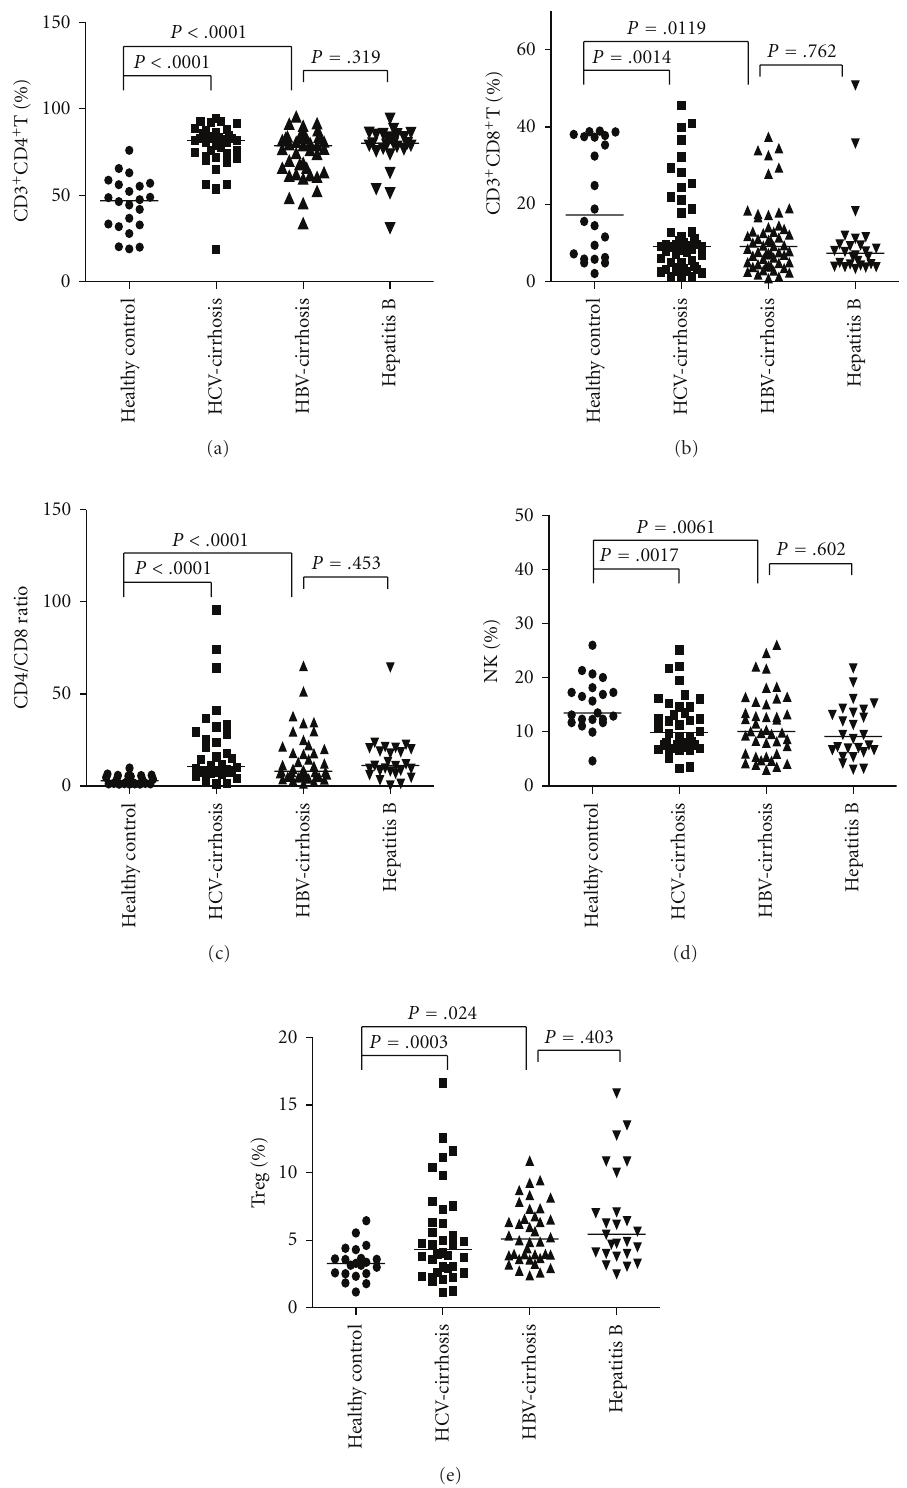
Figure 2: Illustration of lymphocyte subsets in cirrhotic patients and healthy controls. Each symbol represents an individual, and the medians are shown. (a) CD3 + CD4 + T, (b) CD3 + CD8 + T, (c) CD4/CD8 ratio, (d) NK, (e)